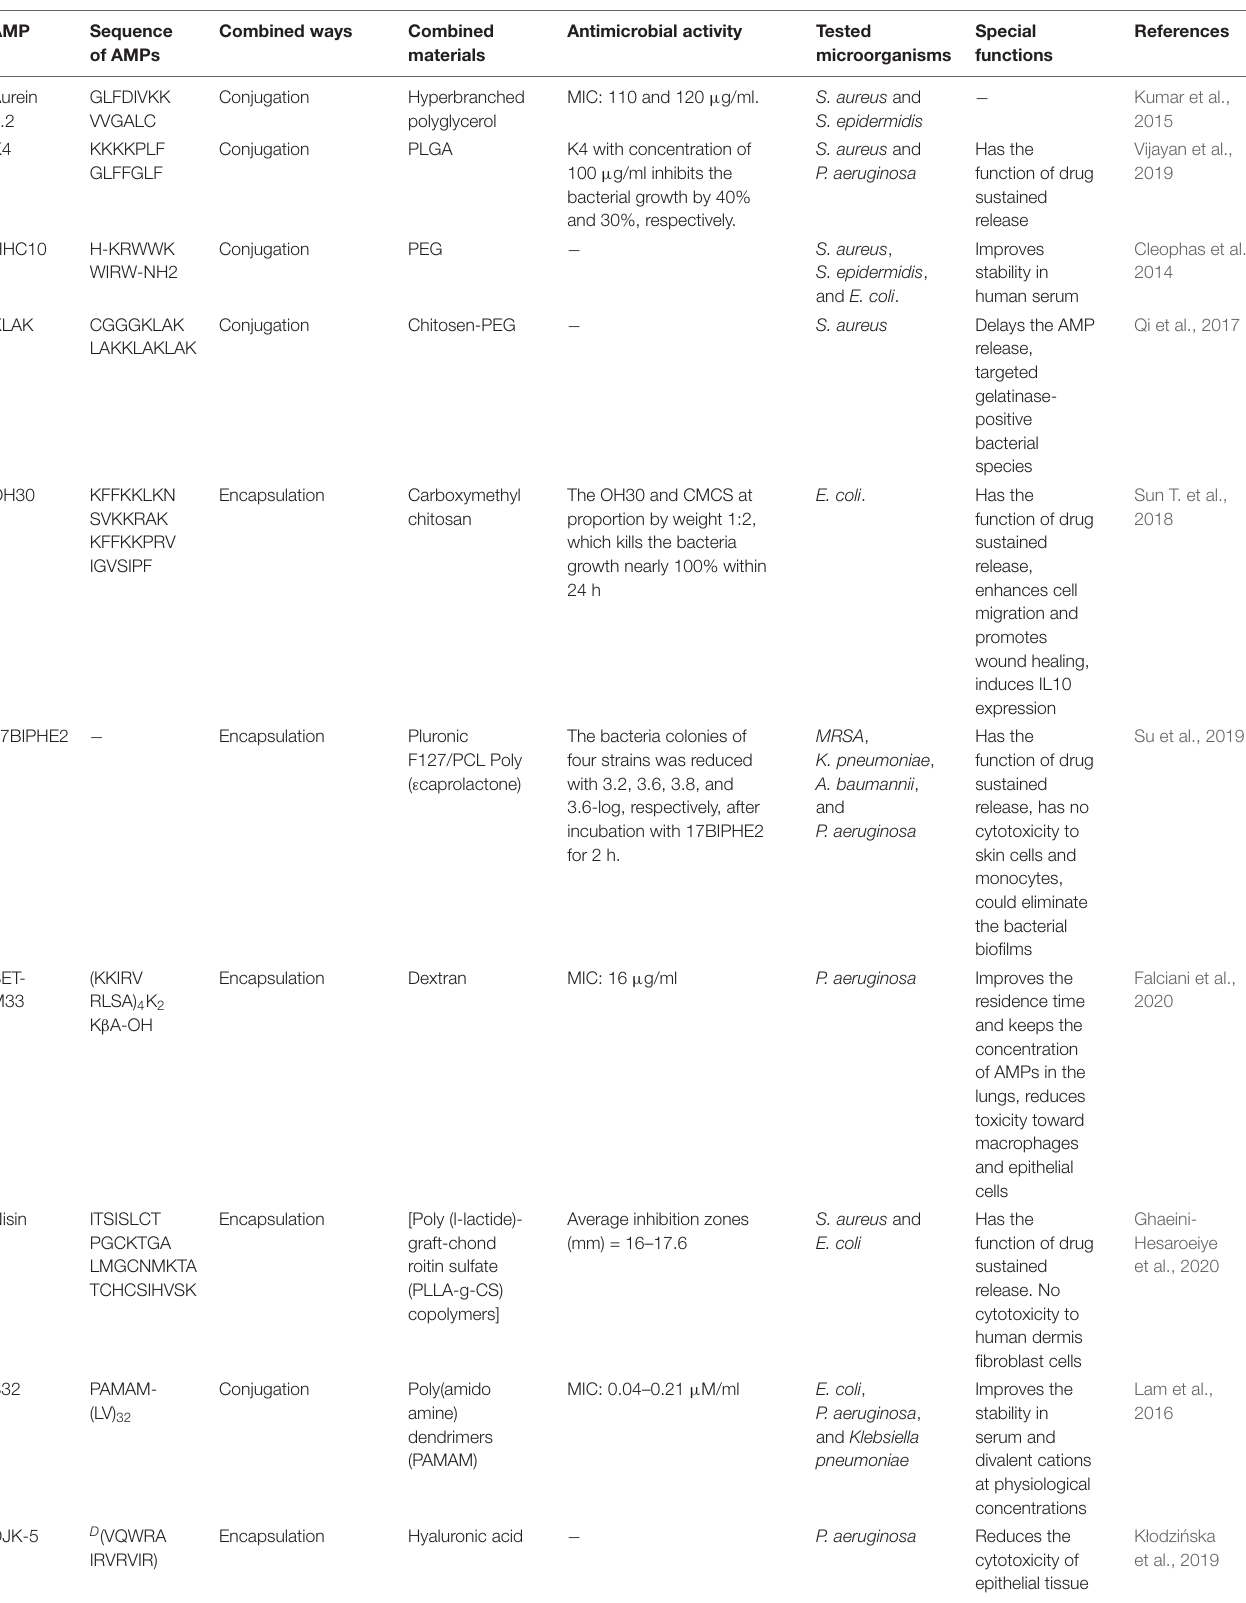
TABLE 2 | Most representative examples of organic material nanosystems containing